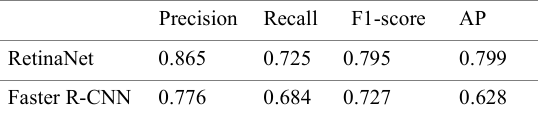
Table 1. Assessment metrics for the vessel detection models on the test set of the WV dataset.